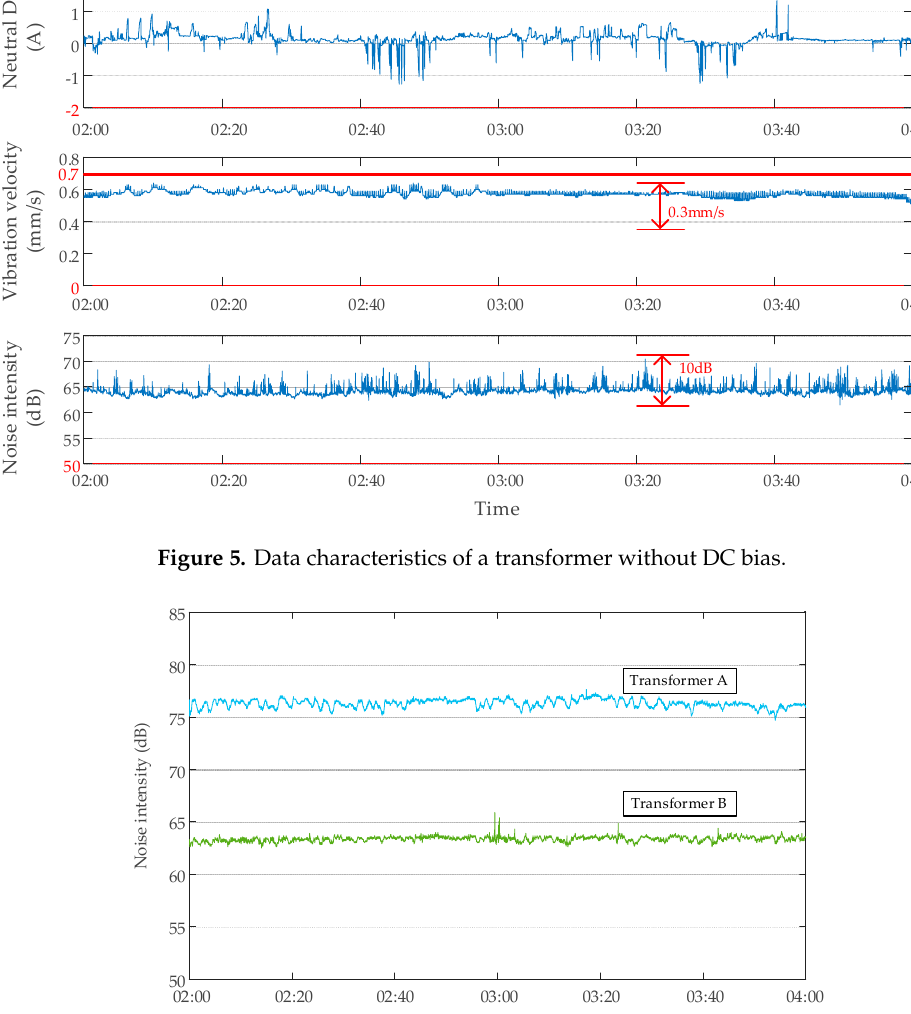
Time Figure 7. The data characteristics of a transformer with DC bias and suppression device off. 2.2.4. Data Characteristics When the DC Bias Occurs and the Suppression Device Is on To obtain the data characteristics when the DC bias occurs and the suppression device is on, the tests were carried out. During the operation of the subway from 14:00 to 16:00, DC bias of the transformer occurred, and the suppression device was on. The monitoring data of neutral point DC, vibration, and noise of a transformer are shown in Figure 8. The data characteristics are like those without DC bias. In addition, considering the particularity of the autotransformer, the DC bias of the autotransformer cannot be effectively suppressed by adding a single suppression device [28]. In this